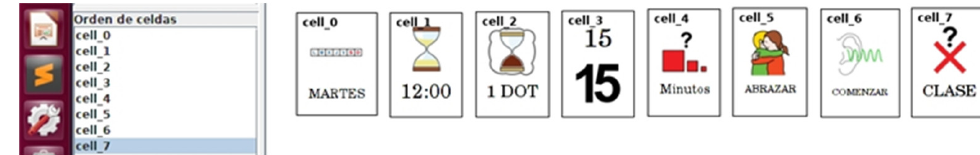
Figure 15. Simple ways to express duration.